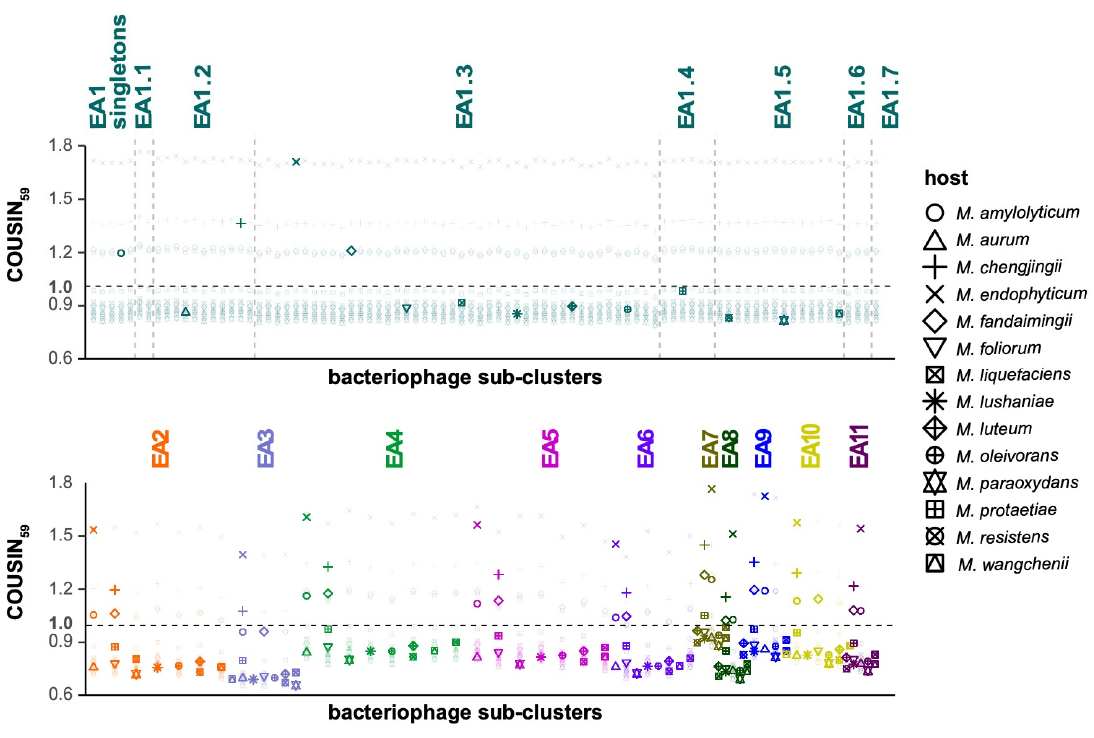
Figure 2. Codon usage bias. COdon Usage Similarity INdex (COUSIN 59 ) of 125 cluster EA bacterio-